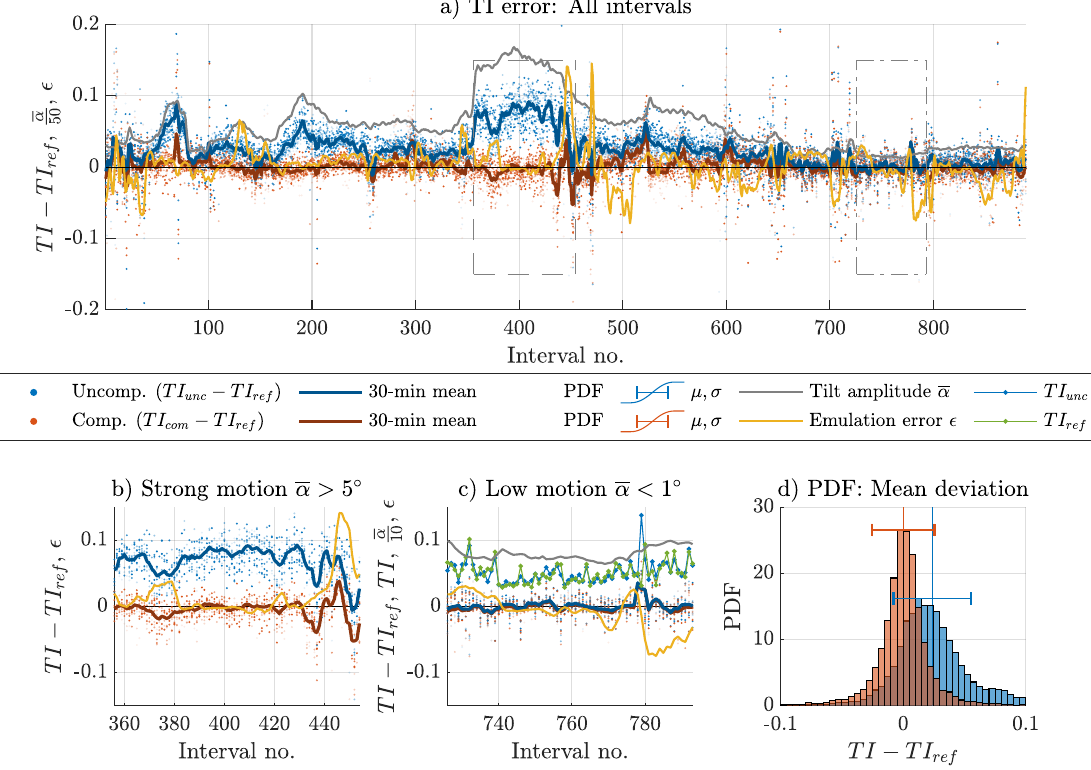
Figure 11. Top: ( a ) Overview of the individual error between TI measured by reference lidar and uncompensated floating lidar (blue) and compensated floating lidar (red). Bottom: Close up view